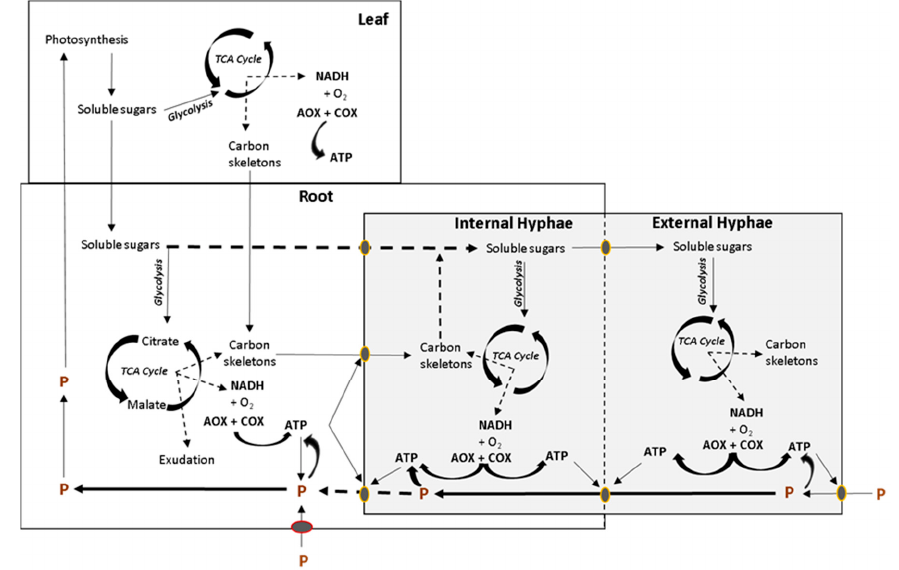
Figure 2. Simplified overview of the interaction between respiratory metabolism of plant organs and mycorrhiza, conditioned by the demand for ATP synthesis and P uptake. Photosynthetic soluble sugars are used in respiration in leaves or transported to the root in order to fuel respiration and produce carbon skeletons for the fungal symbiont. Soluble sugars and organic acids can be exported to the fungal symbiont to fuel respiration in both intra and extraradical mycelium. ATP is required for P uptake and transport across organisms. TCA, tricarboxylic acid cycle. Modified from Hughes et al. [60].